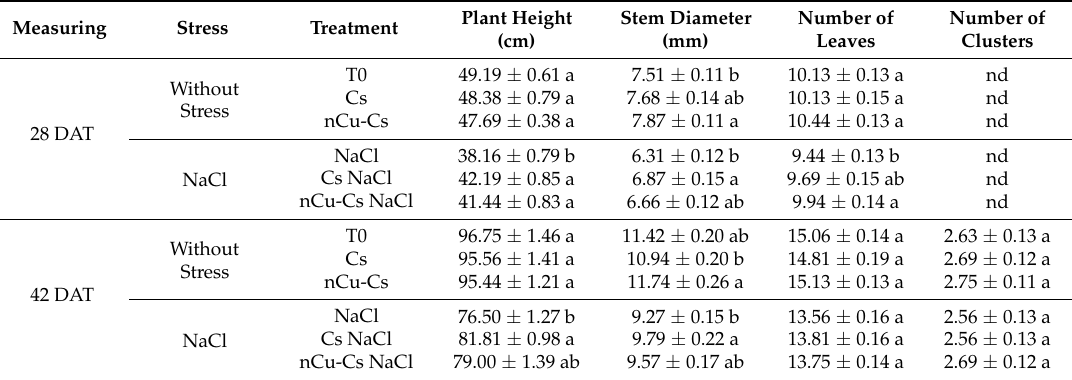
Table 2. Growth parameters of tomato